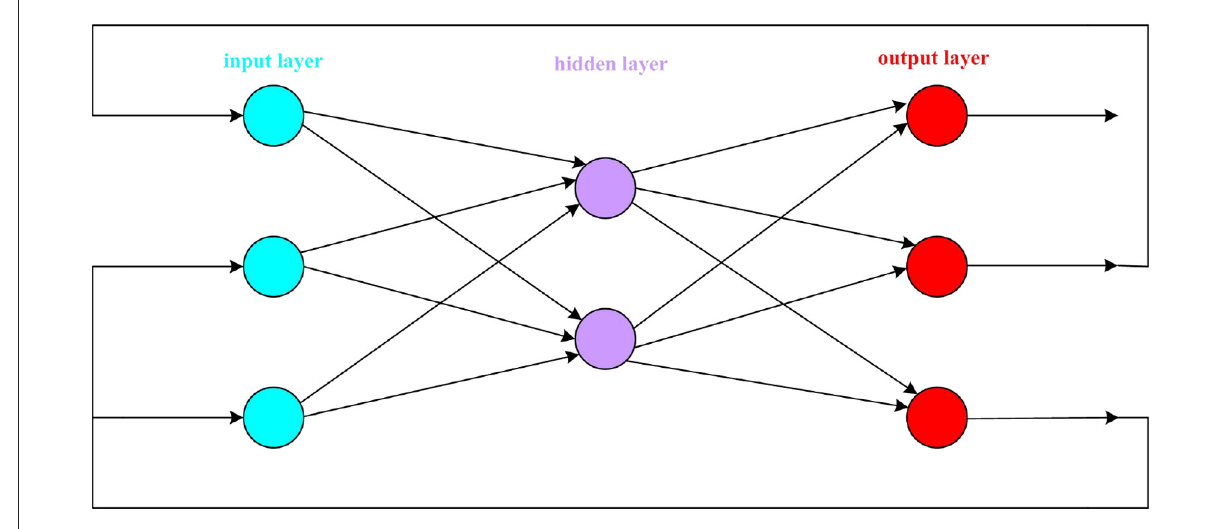
FIGURE5 Feedback network topology diagram.